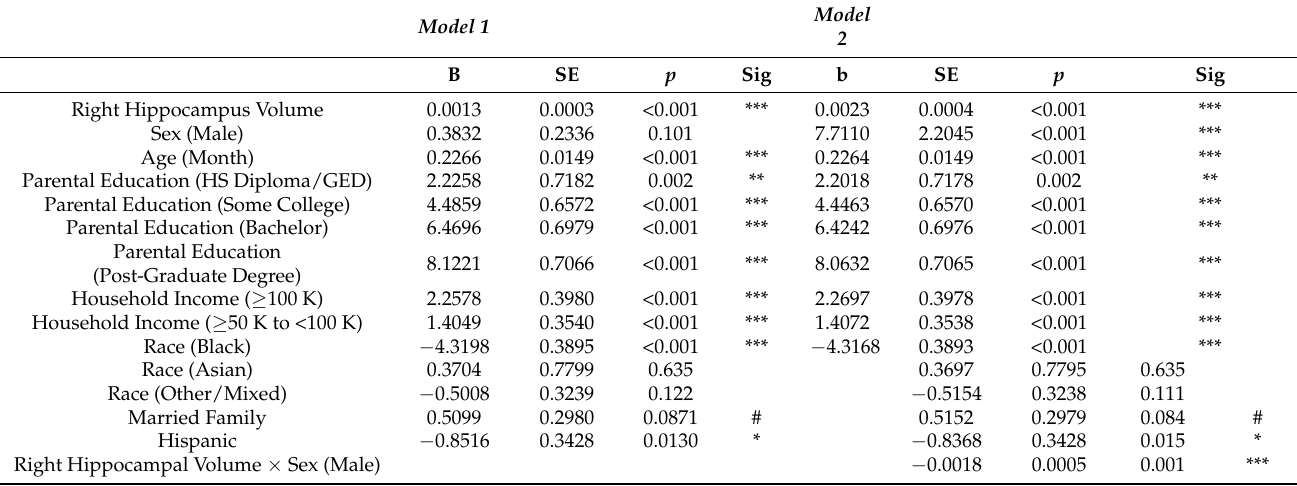
Table 3. Summary of coefficients on the effects of right hippocampal volume on list sorting working